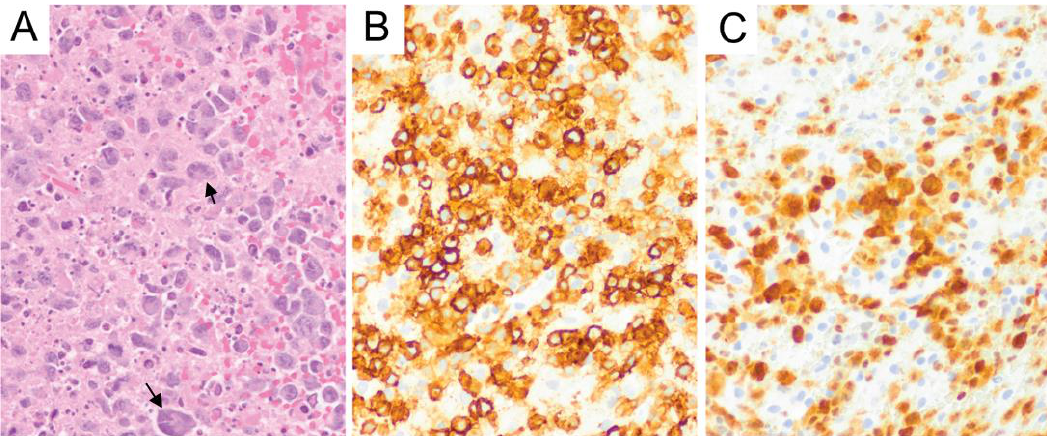
Figure 9. Anaplastic large cell lymphoma. Anaplastic large cell lymphoma is composed of large lymphocytes with frequent “hallmark” cells (arrows), which appear as multinucleated giant cells and Reed-Sternberg-like cells ( A , original magnification ×400). This tumor is immunoreactive for CD30 ( B ), showing membranous and Golgi/perinuclear dot-like staining patterns, and can further be stratified by ALK status ( C ) ( B , C , original magnification ×400).